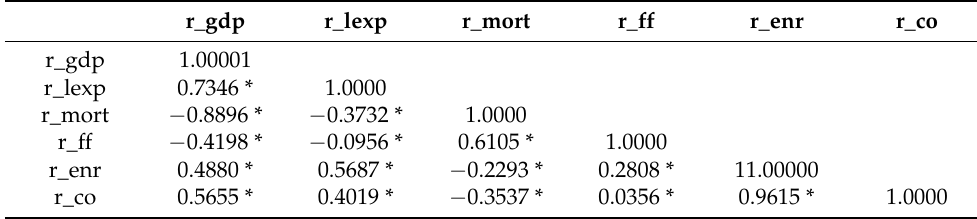
Table 4. Correlation matrix of